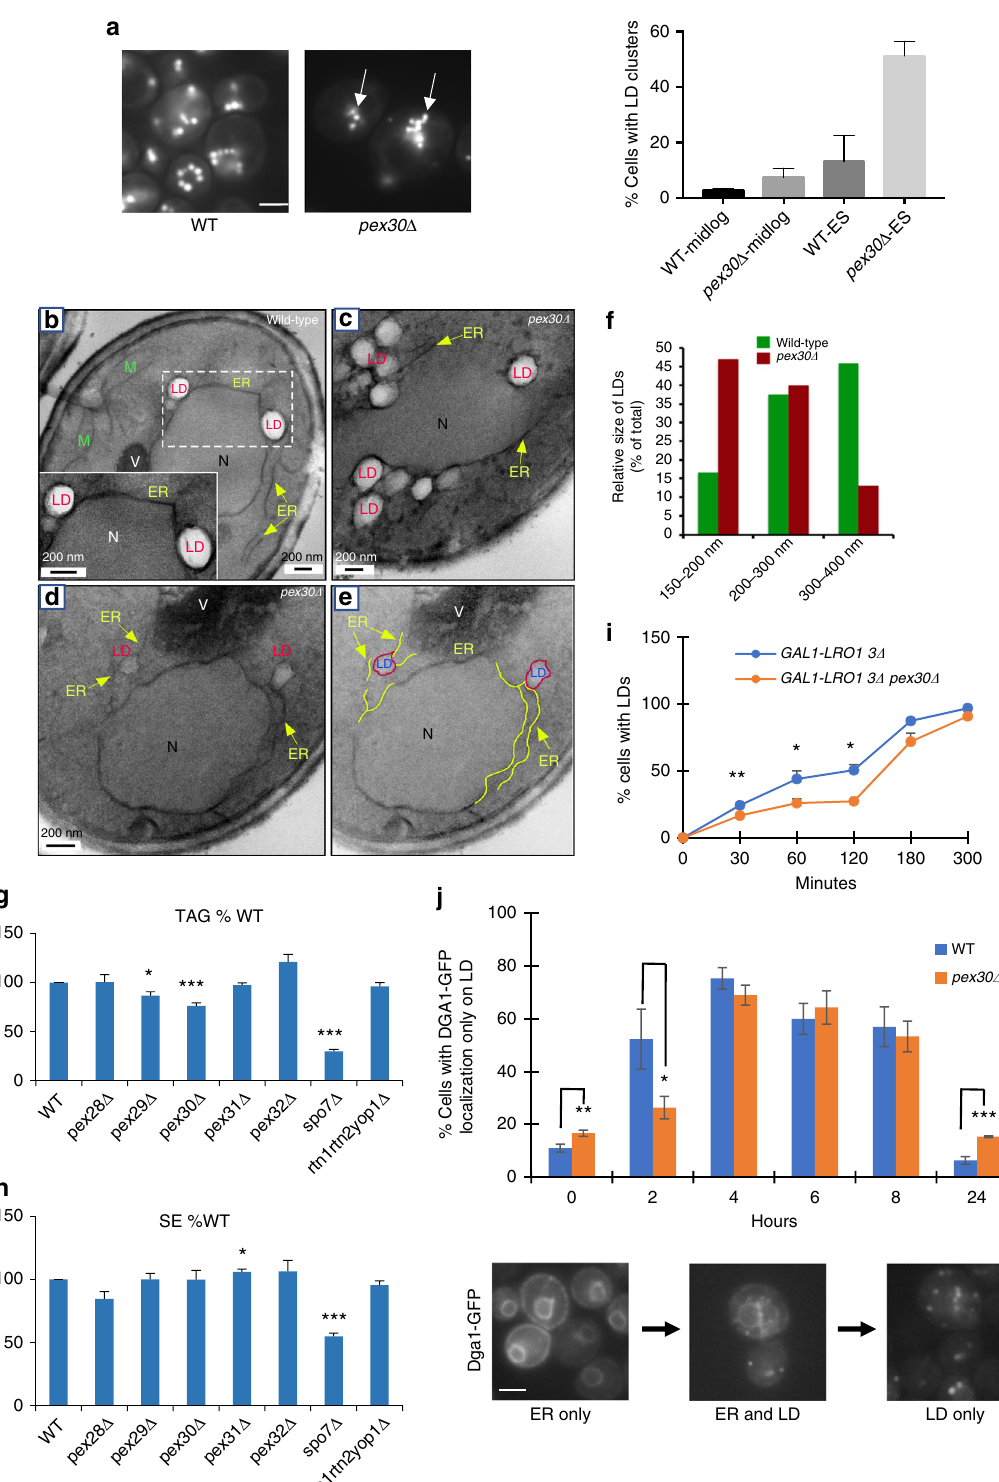
Fig. 3 Cells lacking Pex30 have altered LDs. a Cells in SC were grown to early stationary growth phase and stained with BODIPY to visualize LDs. Stacks of ten images with a step size of 0.2 μ m were taken; images from a single plane are shown. Arrows indicate clustered LDs. Scale bar 3 μ m. Graph indicates mean + / – s.d. of three independent experiments, n = 100 cells; midlog = cells in mid-logarithmic growth phase; ES = cells in early stationary growth phase. b – e Cells growing in SC were fi xed and visualized by EM. Yellow arrows indicate ER. e Shows the same image as ( d ), but with portions of the ER highlighted in yellow. f Quanti fi cation of LD diameter in wild-type and pex30 Δ cells. n = 50 cells. g , h Cells were grown to early stationary growth phase in SC medium containing [ 3 H] acetate and the relative amount of TAG ( g ) and SE ( h ) determined. i Cells were shifted to a medium with galactose (time = 0) and the percent of cells with LDs determined over time; LDs were detected using Erg6-GFP or BODIPY. j Cells expressing Dga1-GFP from a plasmid were grown to stationary growth phase in SC (0 h). Cells were washed, resuspended in fresh media, and the percent with Dga1-GFP only on LDs over time determined. Bottom panels show examples of Dga1-GFP distribution patterns: ER only (left), ER and LDs (middle), and LD only (right). g – j Show mean + / – s.d. of three independent experiments, * p < 0.05, ** p < 0.005, *** p < 0.0005, Student ’ s t -test. Bars = 3 μ m. V vacuole, N Nucleus, LD Lipid